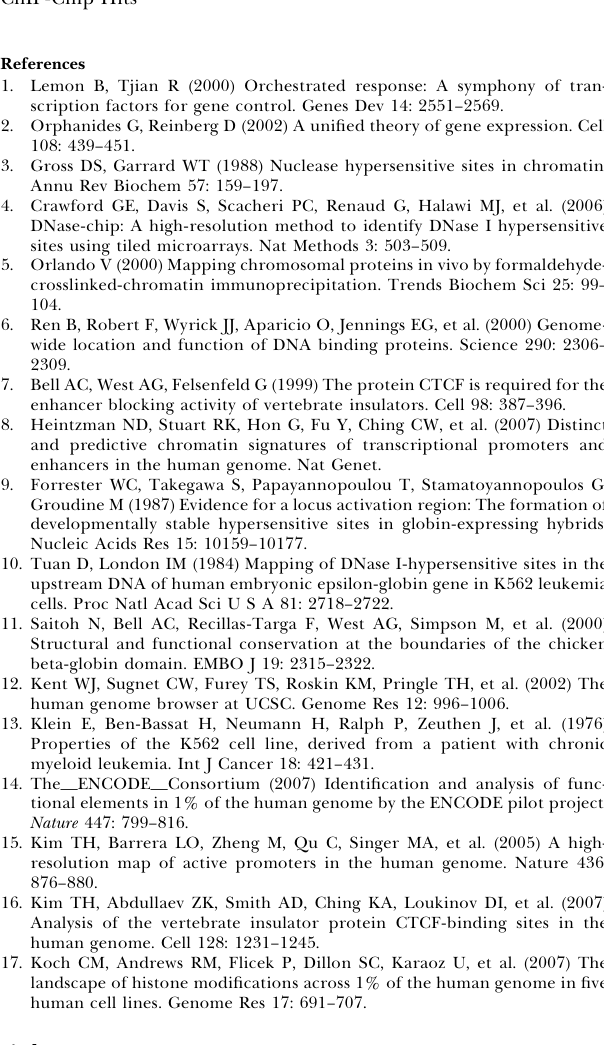
Table S2. Contingency Tables of DNaseI HS versus CTCF Hits Table S3. DNaseI HS Sites Used in Enhancer-Blocking Assay (hg17 Coordinates) Table S4. Enrichment of AP-1 Motif (TGASTCA) in DNaseI HS Sites That Overlap p300 Hits Found at doi:10.1371/journal.pgen.0030136.st004 (27 KB